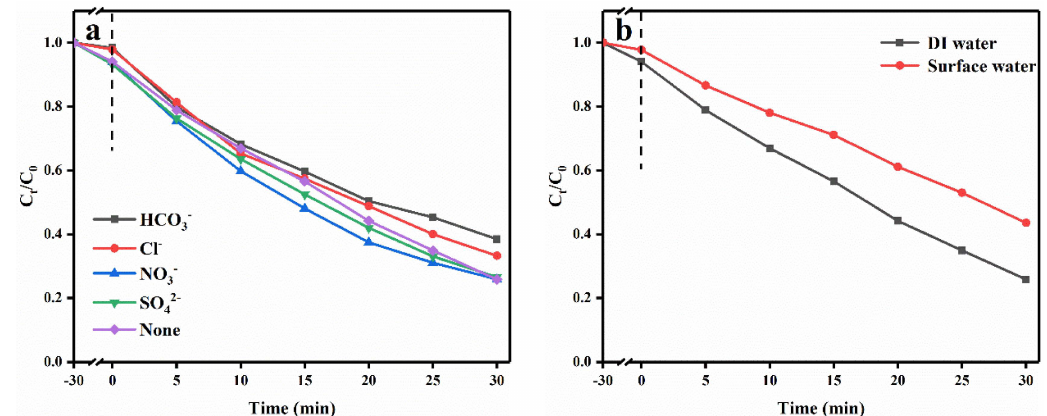
Figure 7. ( a ) Effect of different anions and ( b ) water on the degradation of CIP in the presence of 0.3Bi-BVO (reaction